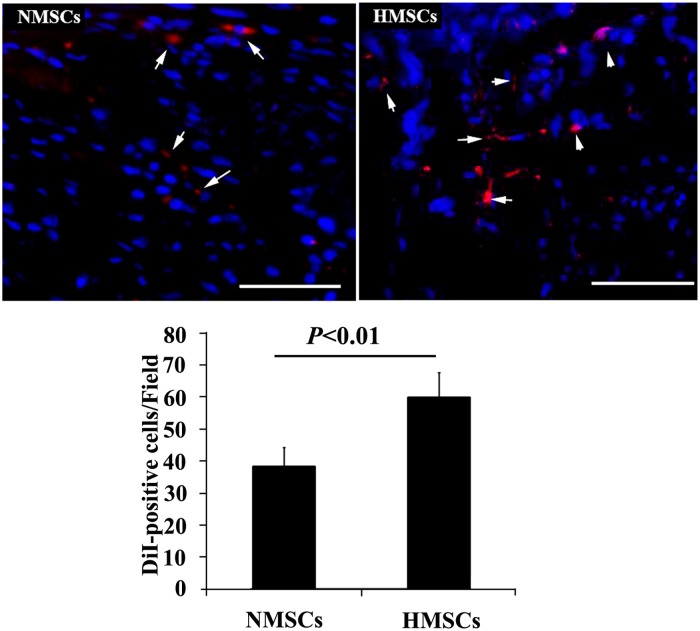
Tracking the engraftment of transplanted cells.Top panel: representative images of DiI-positive AMSCs (red and showed by white arrow) in corpus cavernosum of diabetes induced ED rats receiving intracavernous injection with N-AMSCs (left) and H-AMSCs (right). Bottom panel: The results of quantitative analysis expressed as cell counts summarized per field. More DiI-positive cells were observed in animals receiving HMSCs injection than those receiving NMSCs injection (DAPI staining, Scale bar: 50μm).